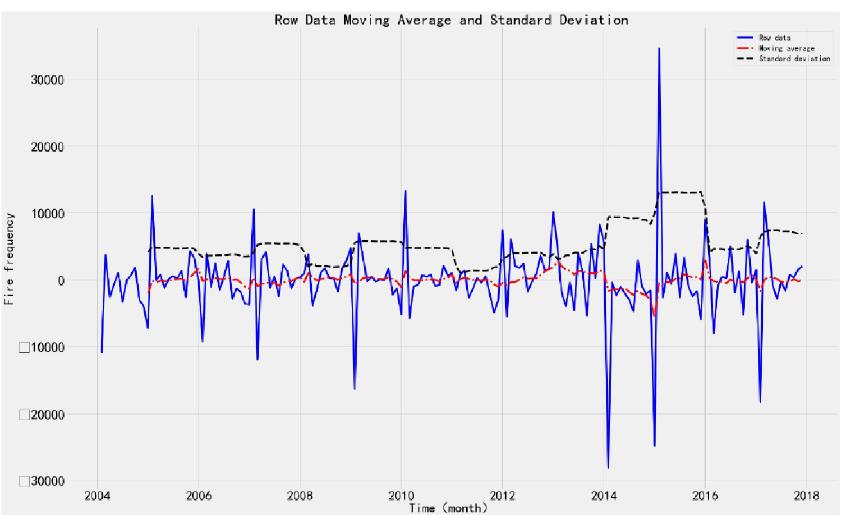
Fig 3. ADF test after 1-order 12 step difference. The sequence chart shows that after the difference of monthly fire quantity the moving average value fluctuates up and down in the value of 0, and the variation of variance with time is very small, indicating that the sequence after the difference is similar to the